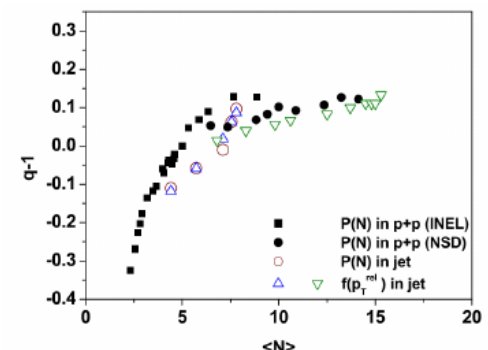
Figure 6. Behavior of the parameter q as a function of multiplicity. It indicates the self-similarity between the system formed at high energy collisions and the jets produced by that system. In addition, it may indicate the region of multiplicity where particle production without the formation of an equilibrated system is relevant. Figure taken from ref.